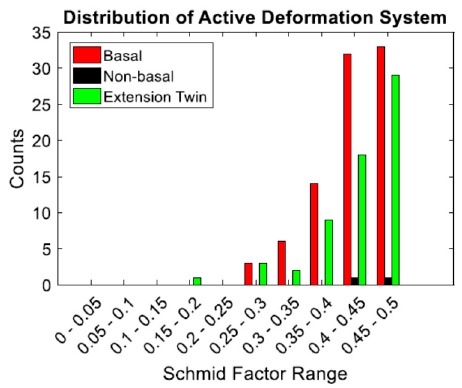
Figure 20. Active deformation modes versus corresponding Schmid factor at uniaxial compression strain of ε = − 4.2% obtained using the SEM-DIC experiment (After Githens et al. [25]).